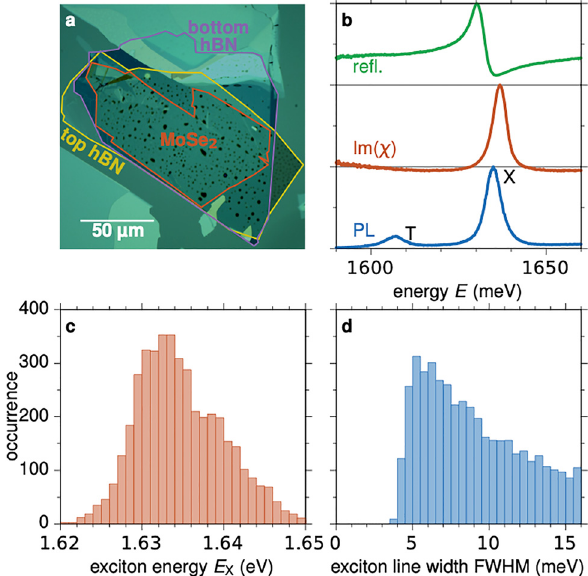
Figure 1: Sample characterization. (a) The white light image of the investigated heterostructure. The bottom hexagonal boron nitride ML in orange, and the top hBN (hBN) is marked in violet, the MoSe 2 in yellow. (b) Typical normalized micro-reflectance (top), the corresponding susceptibility Im( 𝜒 ) (center), and micro-photoluminescence (PL) spectra (bottom) at 5 K, measured around the fundamental exciton transition (X). The trion is marked by T. (c and d) Statistics of exciton center transition energy and linewidth, respectively, illustrating inhomogeneities across the